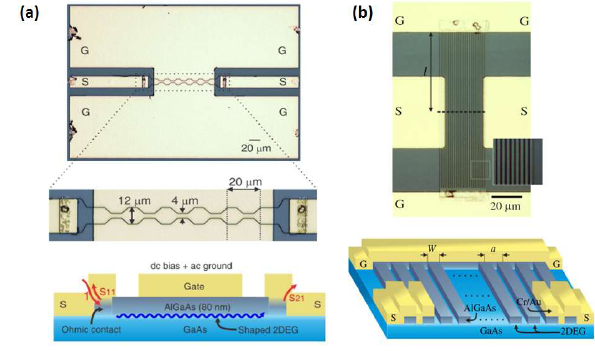
Figure 7: Examples of plasmonic components utilizing shaped 2DEG in GaAs/AlGaAs heterostructures at cryogenic temepratures. (a) From [175]: Optical image (top) and cross-section schematic (bot- tom) of a GHz-regime plasmonic bandgap crystal comprising